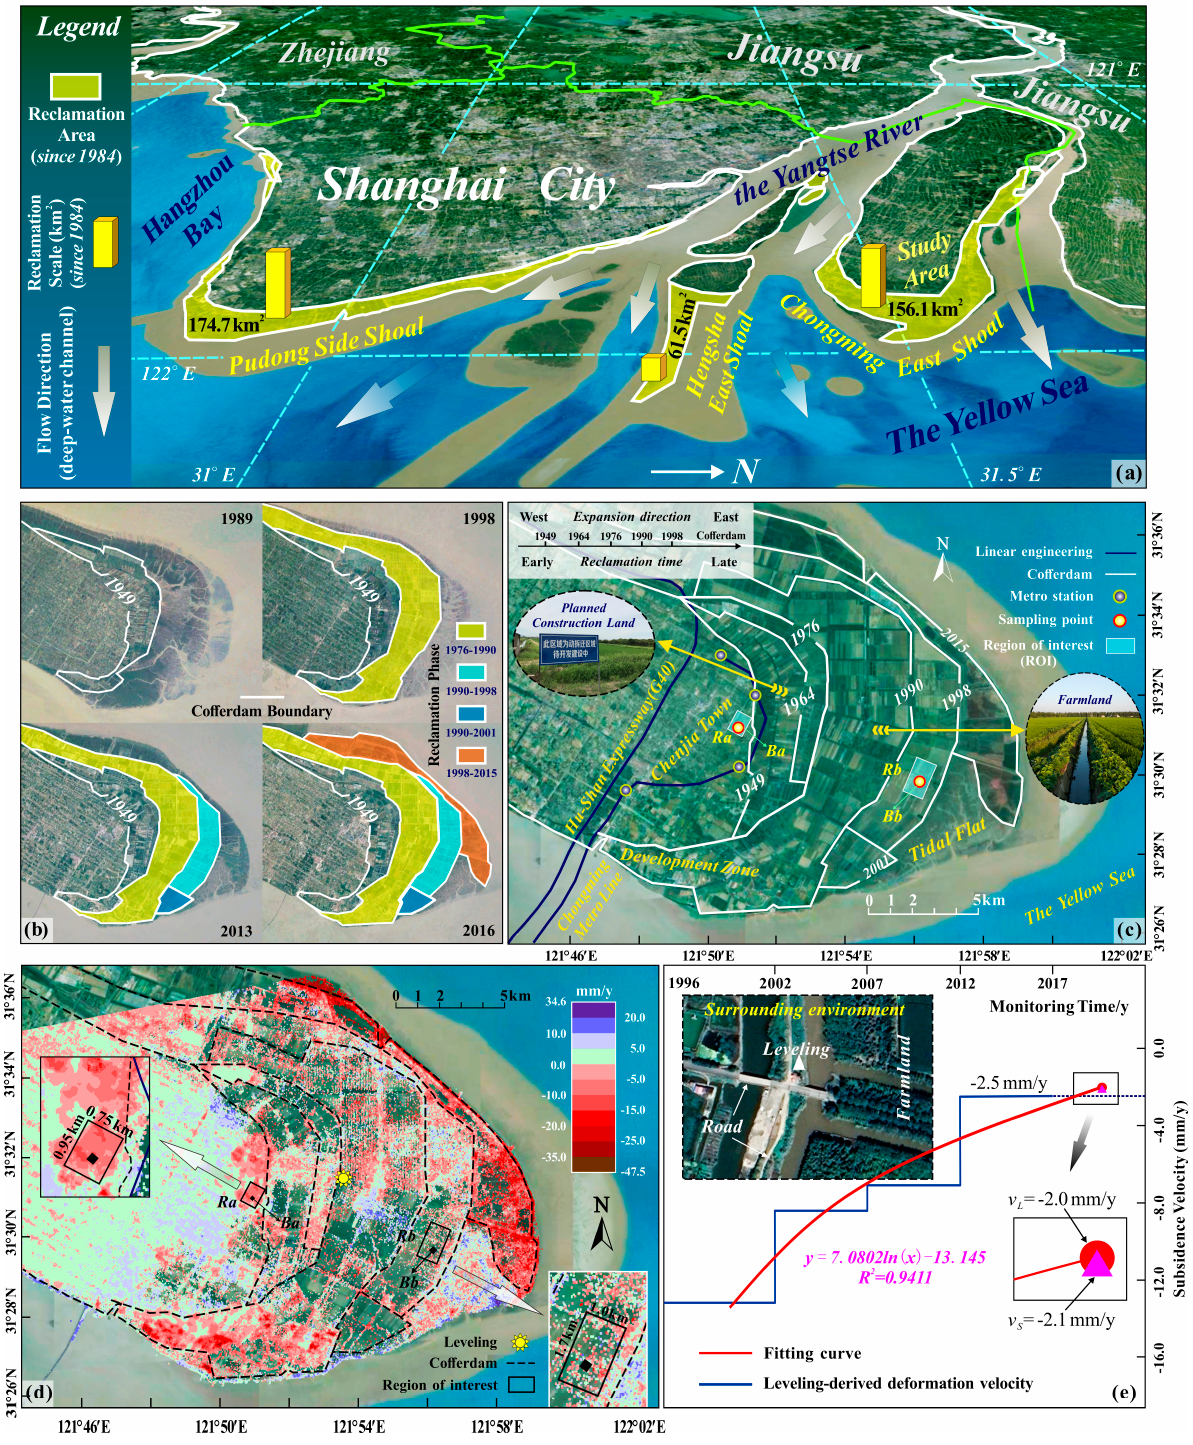
Figure 2. Google Earth-based overview of Chongming East Shoal (CES). ( a ) The main reclamation areas in Shanghai; ( b ) the advancement of multi-phase reclamation projects in CES since the 1990s; ( c ) site environment and land use; ( d ) SBAS- derived vertical deformation map from 22 March 2015 to 2 December 2019 (data from Reference [27]); ( e ) comparison of SBAS-derived deformation velocity ( ν S ) and fitting leveling data ( ν L ) at the leveling location (data from Reference [27]). (Note that the leveling measurement followed the specification of the second-order leveling with an error of 2 mm, based on the Chinese national height data from